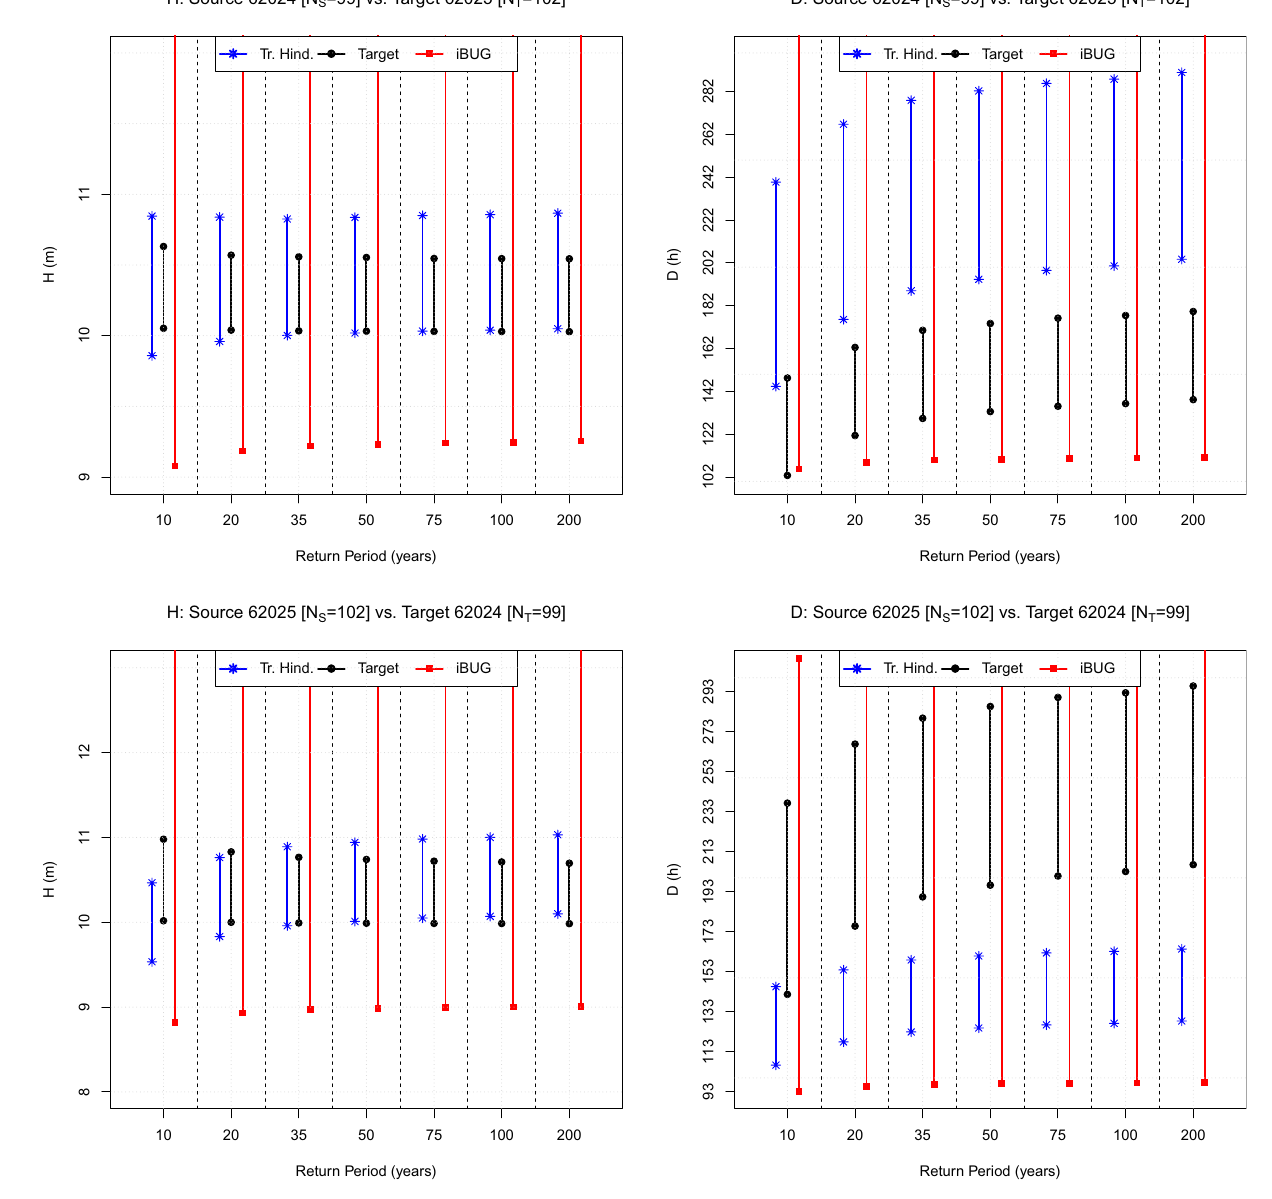
Figure 4. Comparison of Design values: the Bay of Biscay case. The plot shows the CI’s of the Target design values (black) associated with the RP’s indicated on the horizontal axis. The blue and red CI’s represent, respectively, the corresponding estimates computed via the Traditional Hindcasting and the iBUG techniques. The variables of interest ( H and D ) are indicated in the title, as well as the labels of the buoys considered and the Source ( N S ) and Target ( N T ) sample